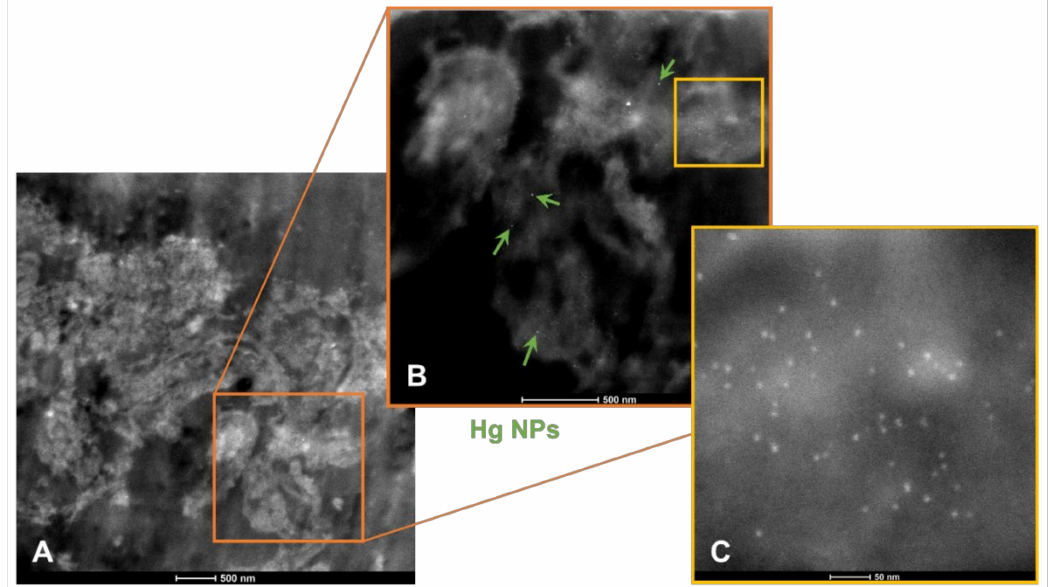
Figure 9. Composite picture of Hg and Fe nanoparticles in telencephalic PCW 12 brain tissues. In panel ( A ), low power view of the sampled brain tissues; in panel ( B ), the brightest nanoparticles are composed of Hg (7–12 nm in range) and are marked with green arrows, and all other NPs are Fe. Panel ( C ) contains Fe NPs mostly in the 4–6 nm